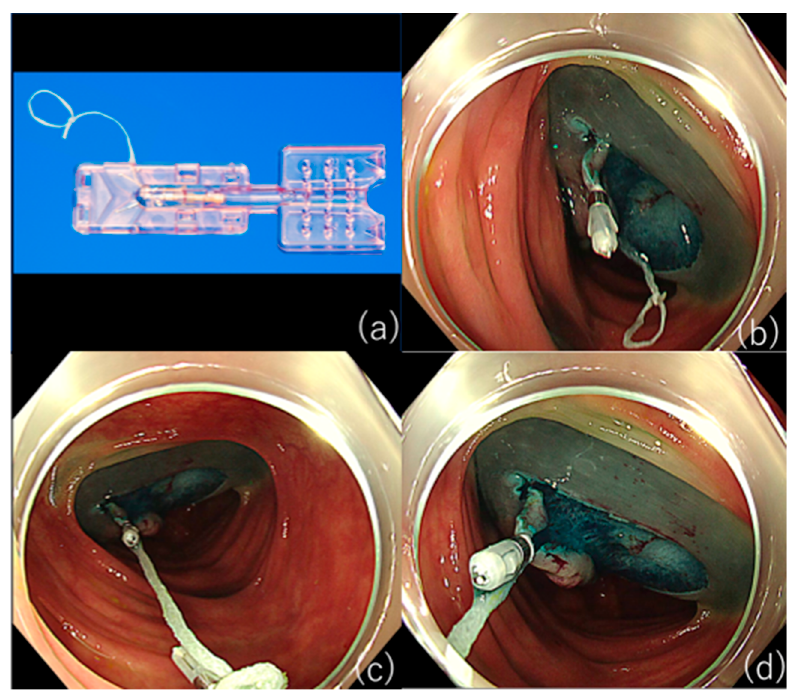
Figure 2. The ring-thread counter traction method. ( a ) A handmade clip with a ring made of dental floss attached to the arm. ( b ) Attach the thread ring to the flap. ( c ) Apply the ring at site 2-fold distant from the anal side of the lesion. ( d ) Good traction was obtained, as in the case of the S-O clip.